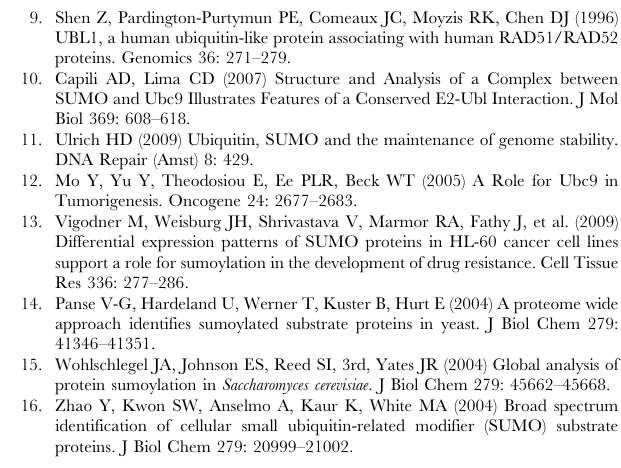
Figure S1 Distances between potential hydrogen bonds. (A) Distance between alpha carbon atoms of residues Arg63 of SUMO and Glu122 of Ubc9 throughout the trajectories. Upper lane is the distance for Ubc9-SUMO-RanBP2 complex, and lower lane is the distance for Ubc9-SUMO complex. (B) Distance between a carbon atoms of residues Gln29 of SUMO and Gln111 of Ubc9 throughout the trajectories. Upper lane is the distance for Ubc9-SUMO-RanBP2 complex, and lower lane is the distance for Ubc9-SUMO complex. Figure S2 Rmsd values for both complexes throughout the simulation. (A) The rmsd values with the alignment of the whole complex structure, throughout the simulation for Ubc9-SUMO complex. The jump in rmsd can be observed around 10 ns. The rmsd values for the same simulation, calculated by alignment of individual chains are illustrated for (B) Ubc9 and for (C) SUMO. The rmsd jump is not observed in B and C. (D) The rmsd values with the alignment of the whole complex structure, throughout the simulation for Ubc9-SUMO-RanBP2 complex. Figure S3 Correlations of mean-square fluctuations. (A) Corre- lations of Ubc9-SUMO overall trajectory. (B) Correlations of Ubc9-SUMO from Ubc9-SUMO trajectory between 24–31 ns of simulation time. In both A and B, the rectangles surround the correlations between His83-Ser89 and Asn121-Ala131 of Ubc9, and correlations between His83-Ser89 and Ala131-Arg141 of Ubc9. (C) The color bar indicating the correlations for both A and B. Figure S4 The projections of Ubc9 conformations on principal components. The projections of Ubc9 conformations from Ubc9- SUMO and Ubc9-SUMO-RanBP3 simulations are given in blue and red, respectively. The principal components are given in A˚ . All plots are in the range [ 2 10:10] in x- and y-axes. The proportion of all trajectory accounted for accounted for by the PCs up to current PC is given in parenthesis on each axis.